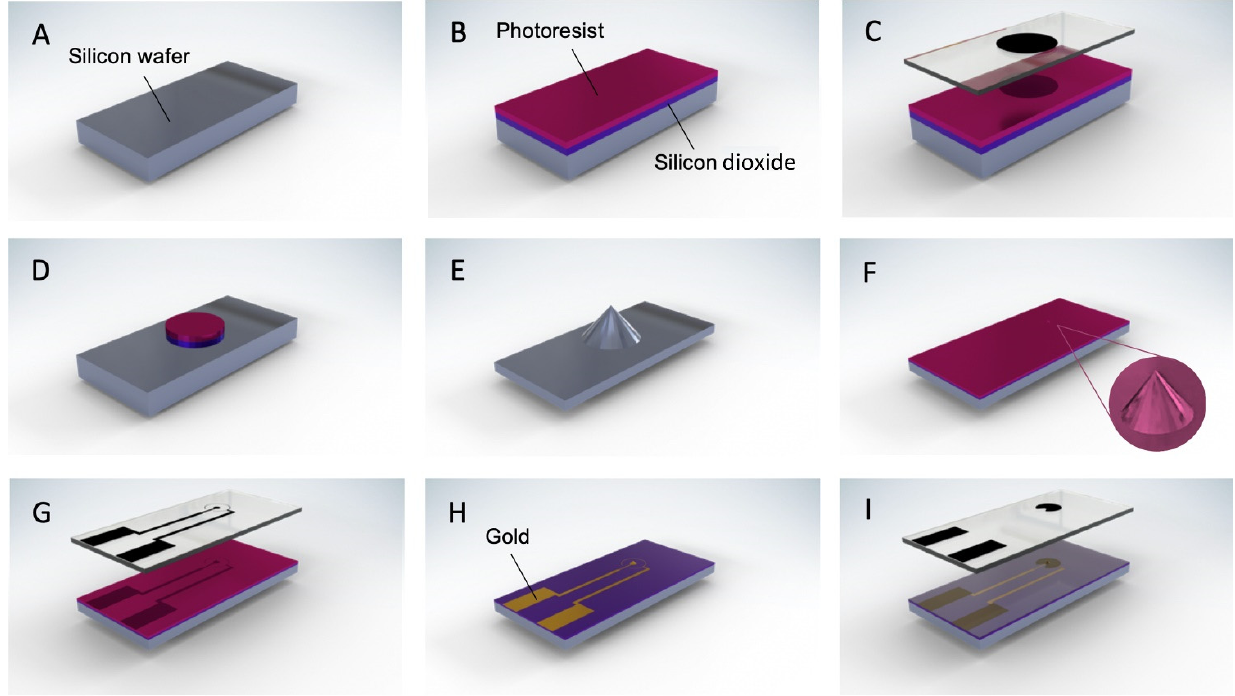
Figure 1. Schematic of device fabrication. The bare silicon wafer in ( A ), is covered by 1 µm of silicon dioxide and 1.6 µm of AZ5214E photoresist ( B ). UV exposure through the first chrome mask ( C ) patterns the wafer with photoresist circles after developing. The non-covered oxide is etched to reveal the same pattern ( D ). Together, oxide and photoresist work as a hard mask during DRIE to obtain the tip structures ( E ). Following, a 1-µm layer of silicon dioxide is deposited by thermal means, along with 2 µm of AZ2020 ( F ). UV exposure through the second chrome mask ( G ) followed by developing, transfers the electrode patterns to the wafer. Ten nanometers of titanium and 200 nm of gold are deposited by electron beam evaporation and overnight lift-off removes the excess metal out of the pattern ( H ). A final 2-µm layer of AZ2020 photoresist is deposited and UV exposure through the third chrome mask ( I ) insulates the whole wafer except the pads and electrode area.